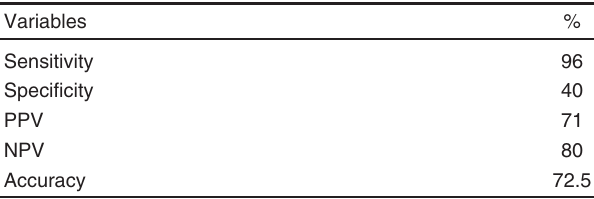
Table 10 Validity of International Physical Activity questionnaire versus diffusion lung capacity for